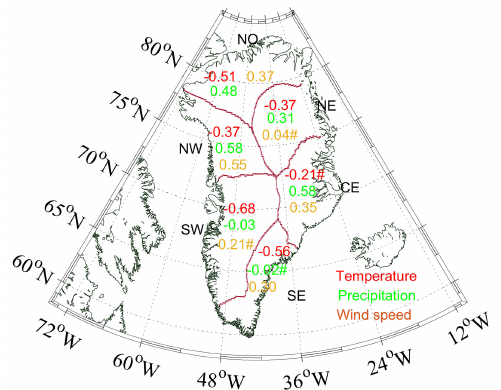
Figure 10. Correlation coe ffi cients of climate variables and mass changes for the six basins of Greenland. Red values represent the correlation between the surface temperature and mass changes, green values represent the correlation between the cumulative precipitation and mass changes, and orange values represent the correlation between the 700 hPa wind speed and mass changes. All correlations with # represent p value >